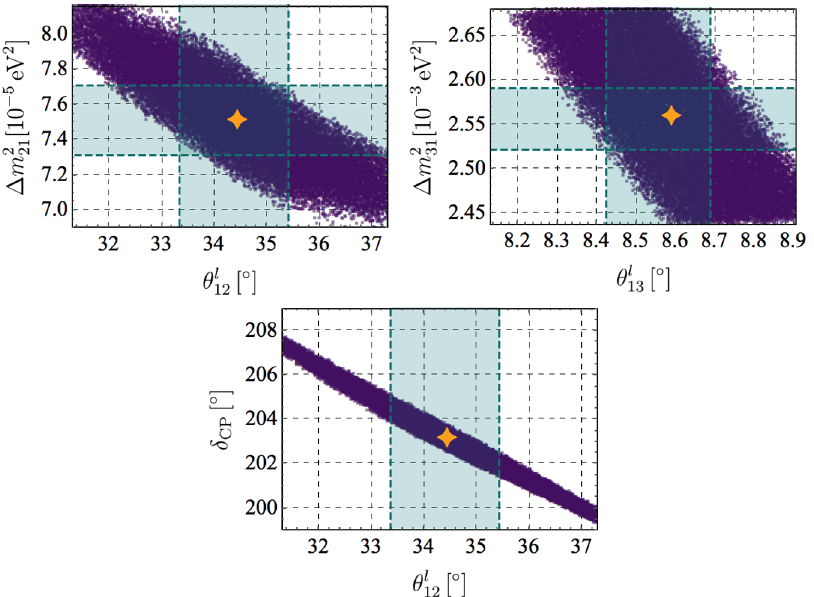
Figure 3 . Correlation between neutrino observables around the benchmark point. The star corre- sponds to the benchmark point considered in the text, whereas the dashed lines correspond to the experimental 1 σ ranges of [79].